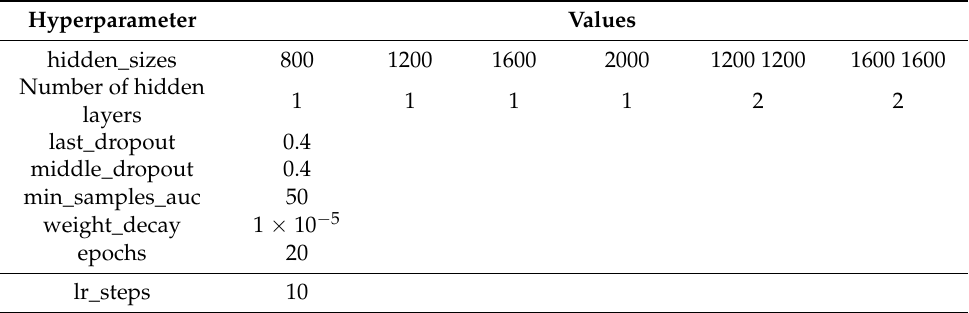
Table 2. Overview of analyzed hyperparameters. Two numbers, e.g., “1200 1200”, in the “hid- den_size” row indicate two hidden layers. “middle_dropout” only applies if the network consists of multiple